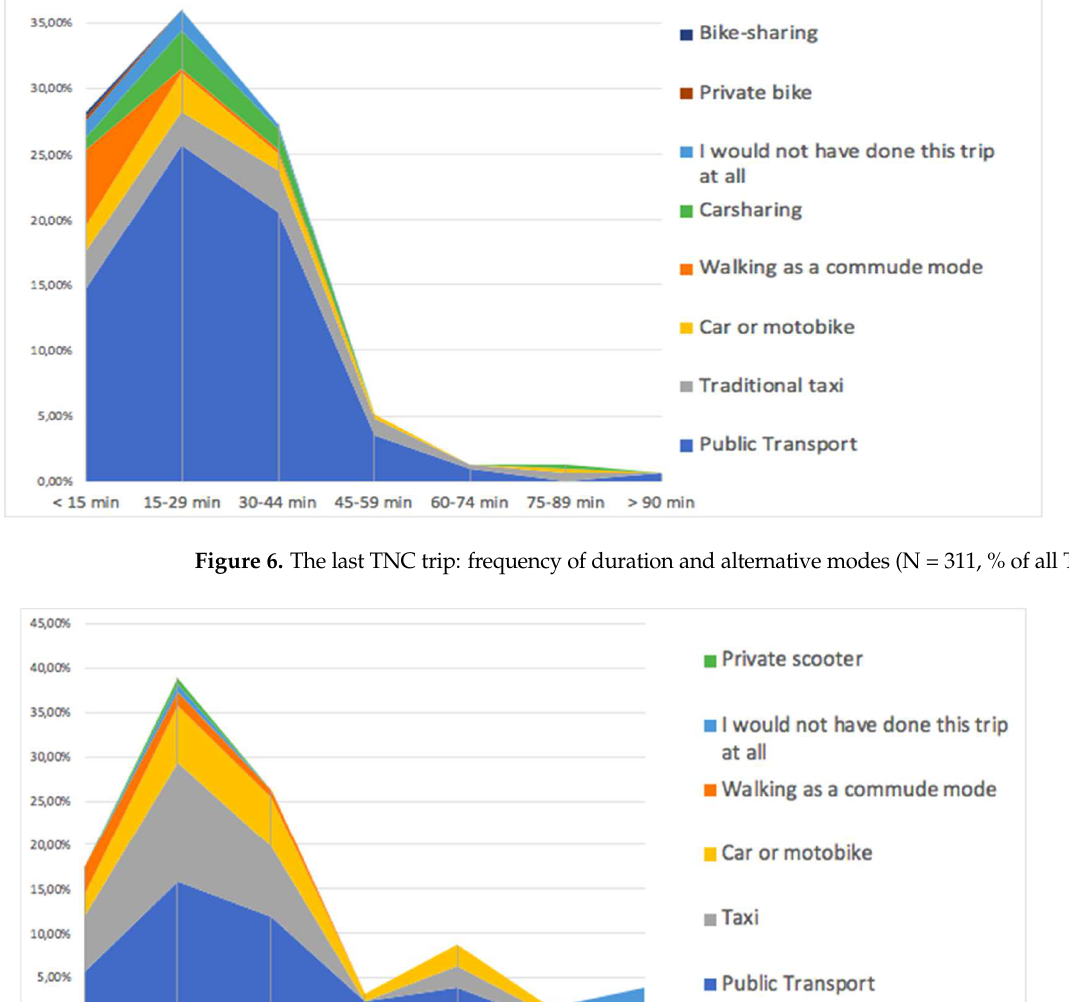
Figure 7. The last car-sharing trip: frequency of duration and alternative modes (N = 126, % of all car-sharing users). In the figure, “Taxi” includes traditional taxis and TNC.